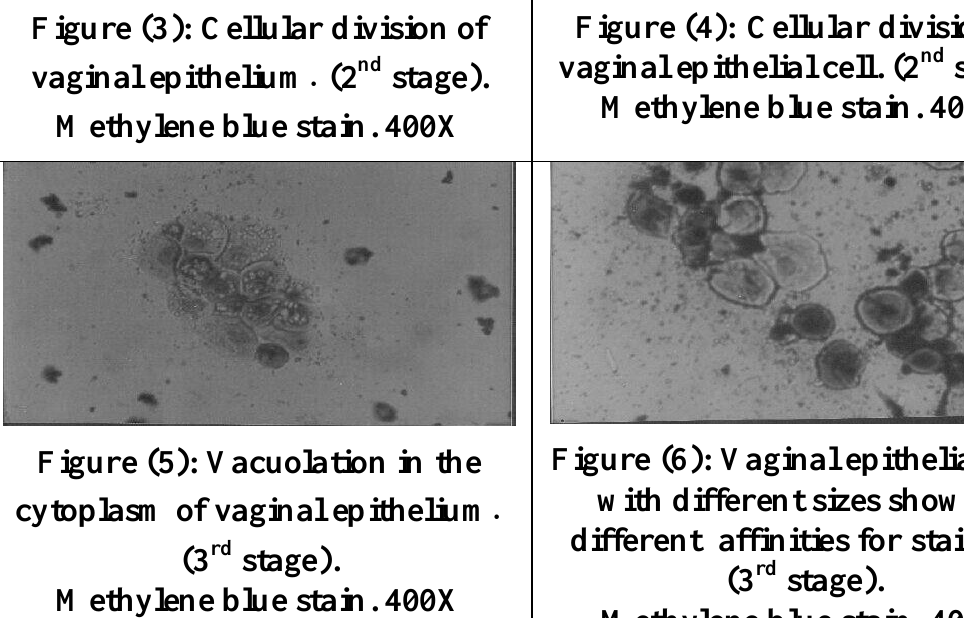
Figure (4): Cellular division of vaginal epithelial cell. (2 nd stage). Methylene blue stain. 400X